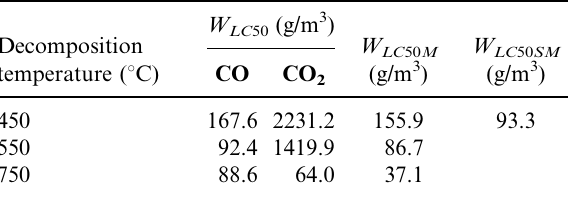
Table 7. Toxicometric indicators of unmodified polyester